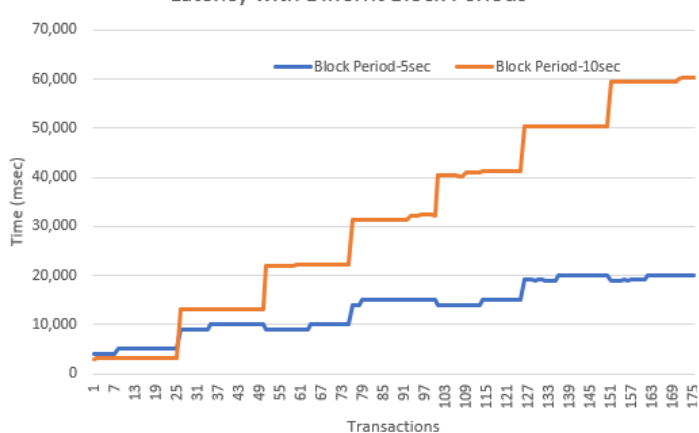
Figure 14. Latency with different block